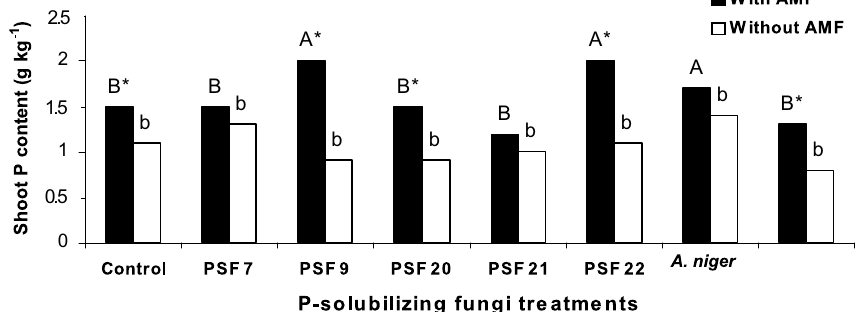
Fig. 2 – Shoot P content of clover inoculated with P-solubilizing fungi from Paraty, Rio de Janeiro, Brazil (PSF 7, 9, 20, 21 and 22) and from Granada, Spain ( A. niger and Y. lipolytica ), in the presence or absence of AMF. (Lower-case and upper-case letters compare PSF treatments in the absence and presence of AMF inoculation, respectively, by the Scott-Knott test ( p ≤ 0 . 05 ) . *: indicates AMF effect by the F test ( p ≤ 0 . 05 )